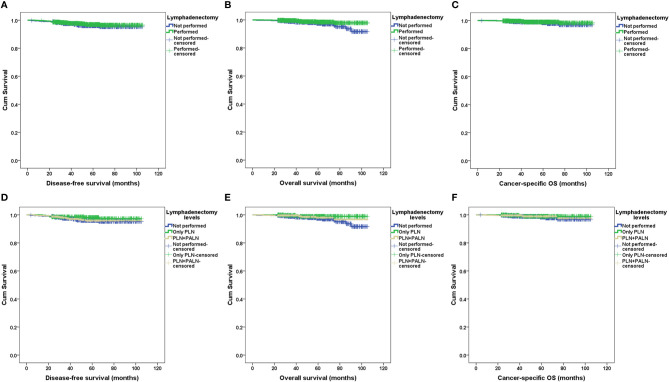
Survival outcomes between patients with and without retroperitoneal lymphadenectomy and various levels of lymphadenectomy by Kaplan–Meier analysis. DFS, disease-free survival; OS, overall survival; PALN, para-aortic lymph nodes; PLN, pelvic lymph nodes. (A) DFS in patients with and without lymphadenectomy. (B) OS in patients with and without lymphadenectomy. (C) Cancer-specific OS in patients with and without lymphadenectomy. (D) DFS in patients with various lymphadenectomy levels. (E) OS in patients with various lymphadenectomy levels. (F) Cancer-specific OS in patients with various lymphadenectomy levels.